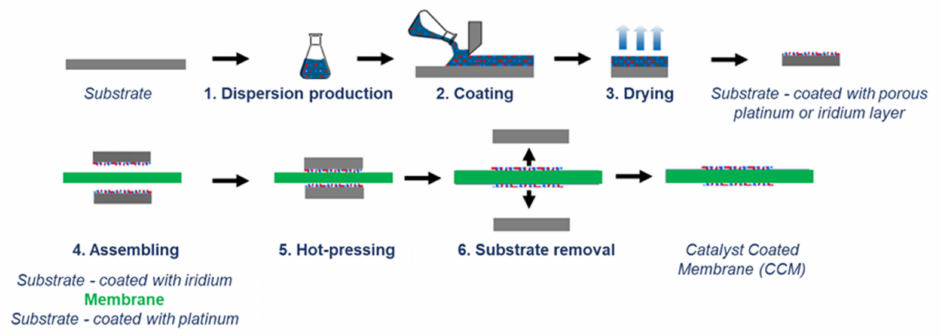
Figure 2. Process steps for producing an MEA using the decal process.